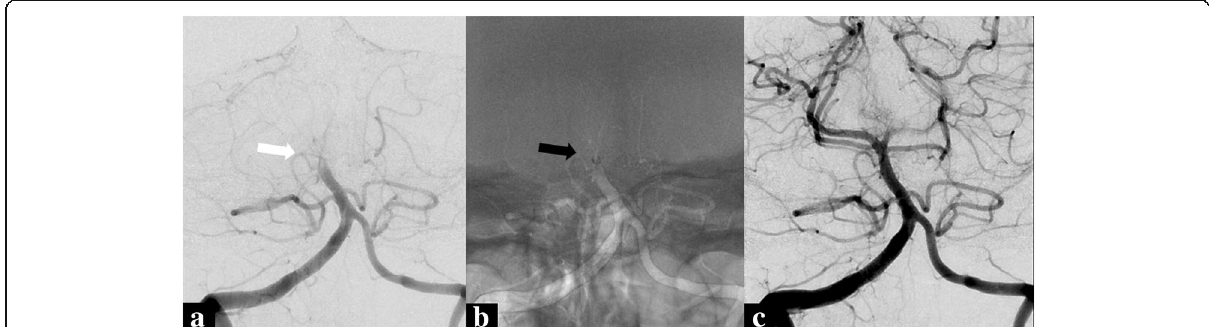
Fig. 7 A 72-year-old woman with a left hemi-paralysis, dysarthria, and anisocoria (NIHSS 22). She was treated initially with IV thrombolysis but did not recover and was referred to our department for EVT. Catheter angiography, AP projection, with contrast injection in the dominant right vertebral artery reveals a midlevel occlusion of the basilar artery ( a , white arrow). Thrombus removal by means of an aspiration catheter was attempted as illustrated by a fluoroscopy image with vessel road map projection ( b , with the black arrow at the level of the catheter tip at the proximal end of the thrombus). After thrombus aspiration, an AP projection angiogram showed successful recanalization with patency of the basilar artery ( c